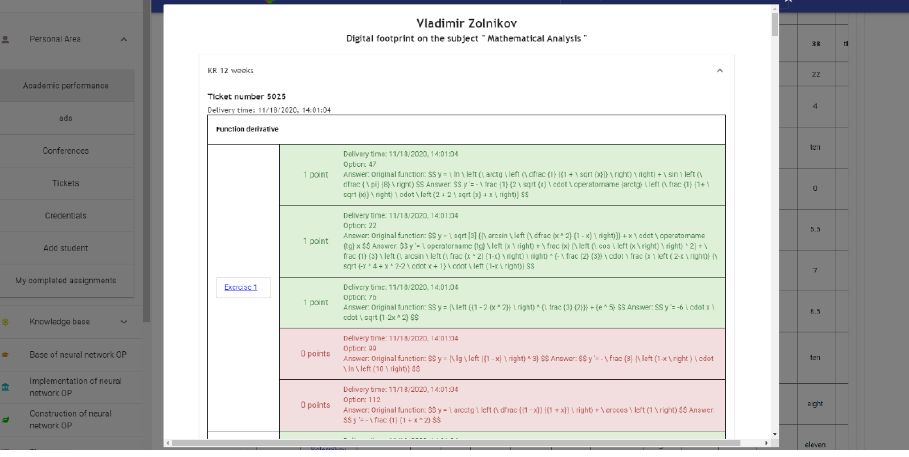
Fig. 8 . Window of the subsystem «Digital Trace» in the Nomotex